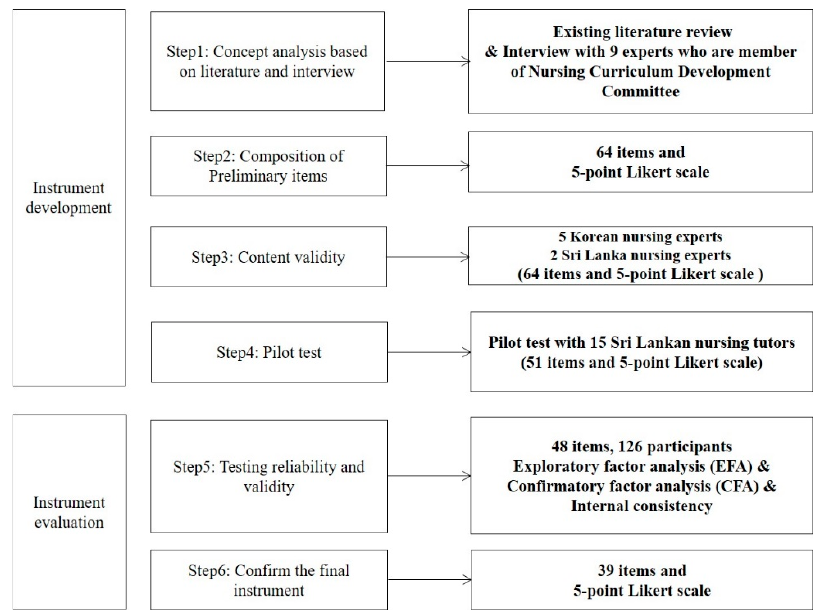
Figure 1. Scale development